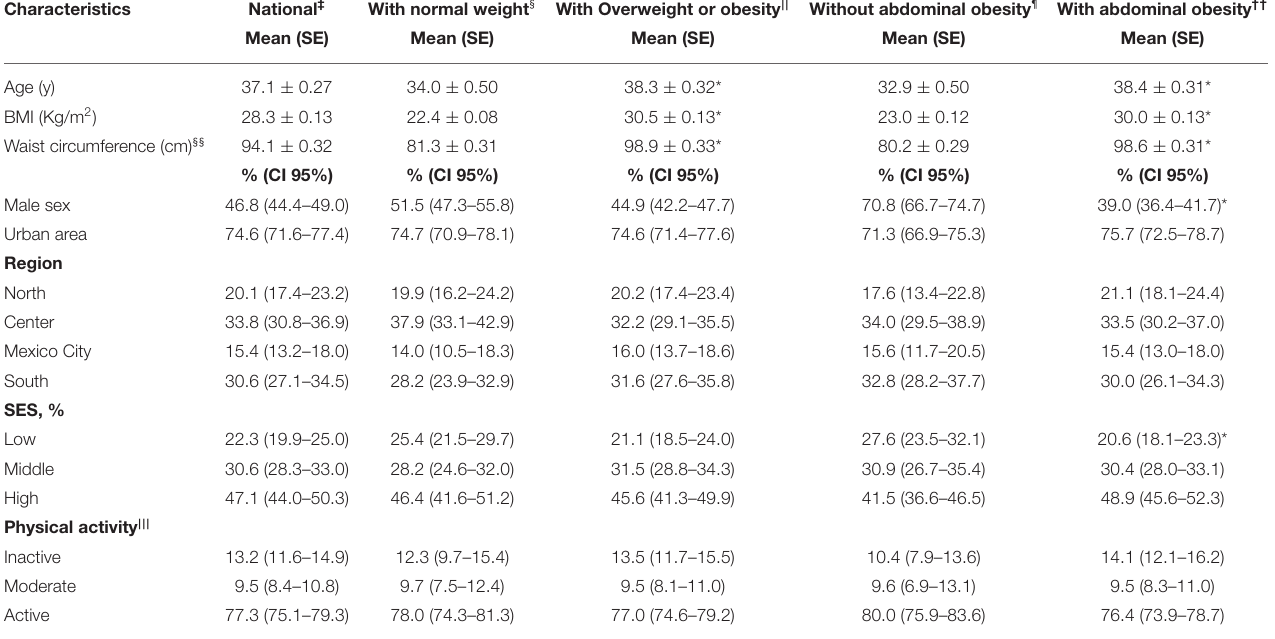
TABLE 1 | General characteristics of Mexican adults population National Health and Nutrition Survey 2016 †